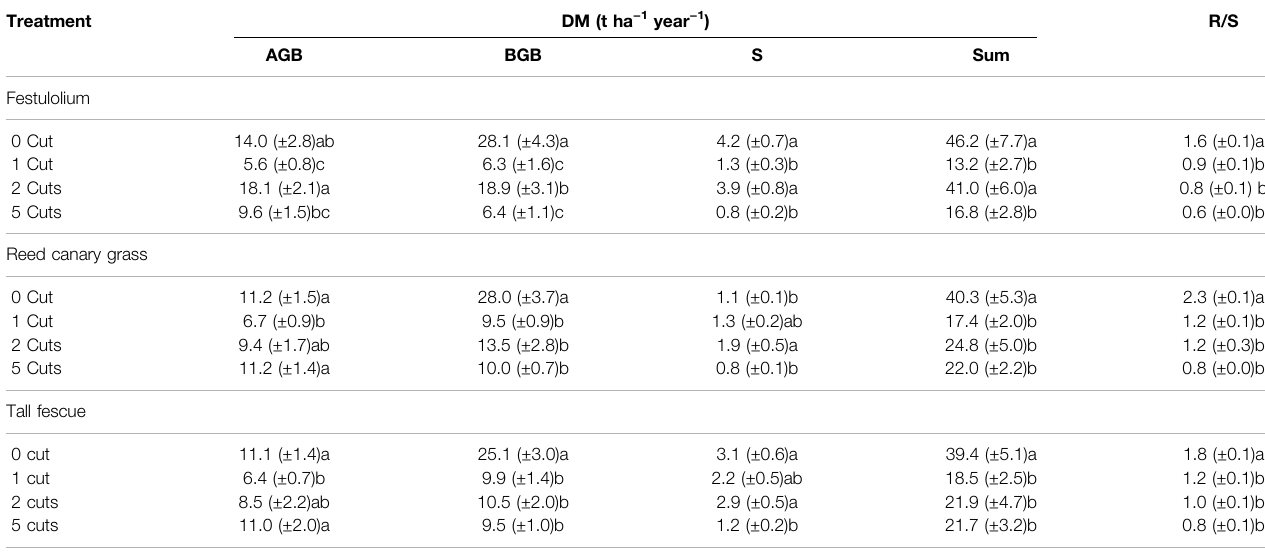
TABLE 2| Yieldsofdrymatter(DM)ofaboveground(AGB),belowground(BGB),and stubble (S)biomass forthevariousspeciesandtreatments.Totalyieldsforabove- and belowground plant fractions are indicated as sums. The root to shoot (R/S) ratio indicates the ratio of belowground to combined aboveground and stubble biomass. Letters indicate differences between treatments, where treatments with the same letters are not signi fi cantly different. Standard error is given in brackets (n (cid:2) 5). Treatment